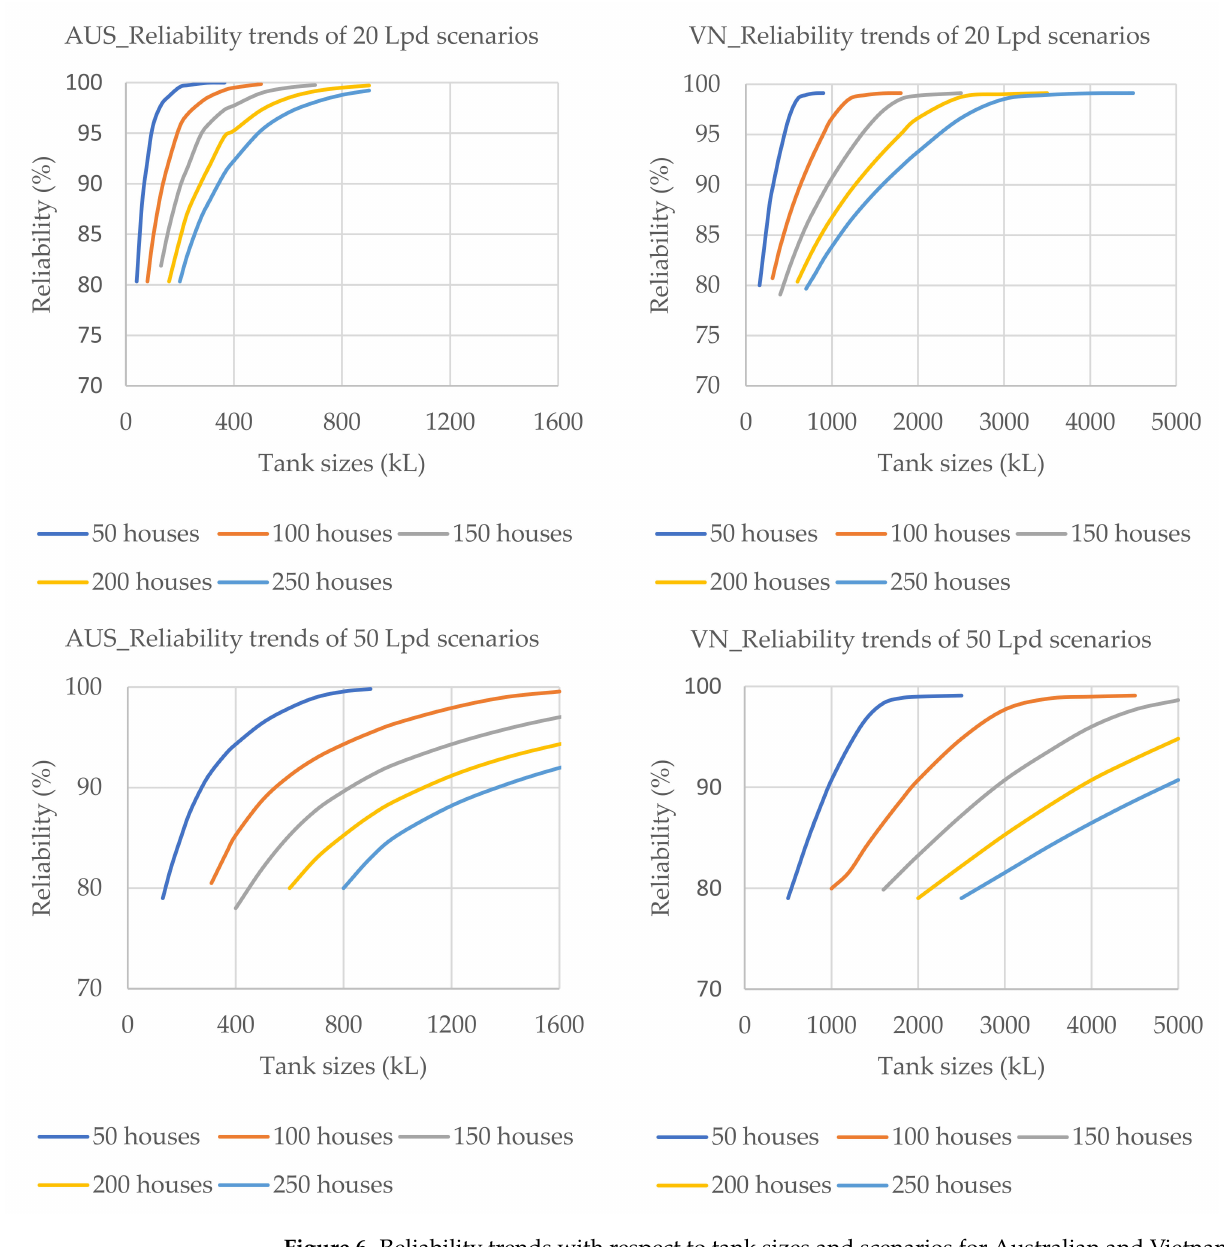
Figure 6. Reliability trends with respect to tank sizes and scenarios for Australian and Vietnamese RWH